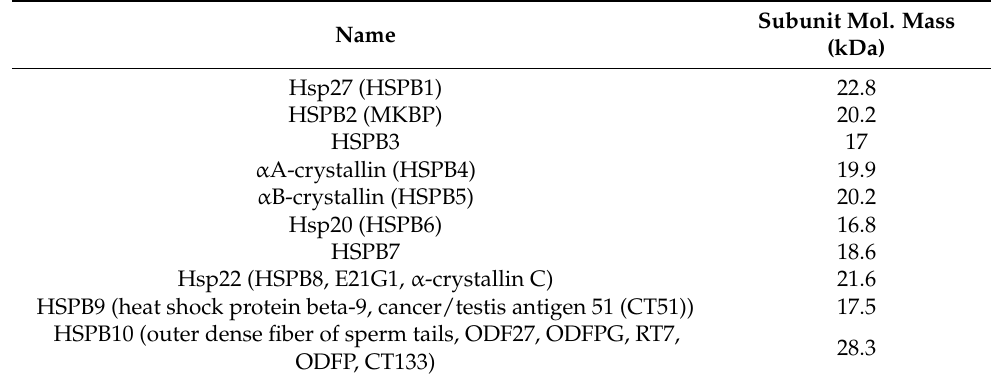
Table 1. Nomenclature of human small heat shock proteins.